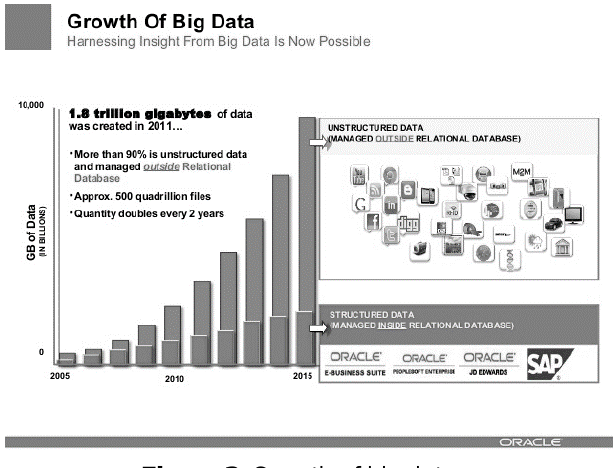
Figure 2. Growth of big data